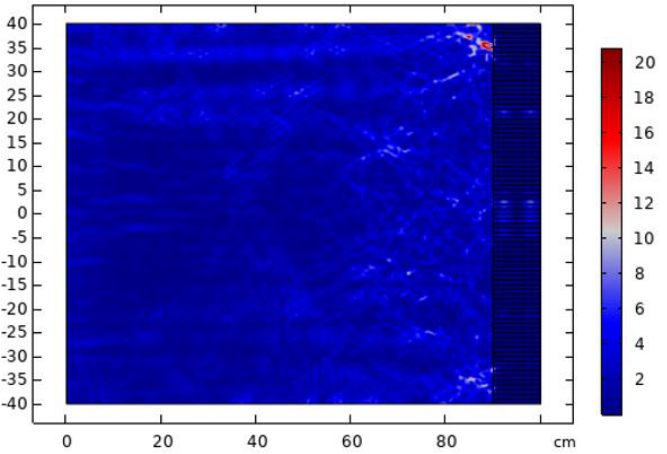
Figure 17. Spatial distribution of acoustic intensity field through focusing lens at 50